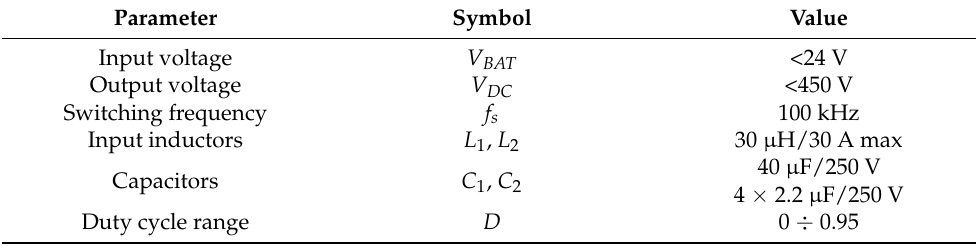
Table 1. Selected parameters of double-boost DC-DC converter.